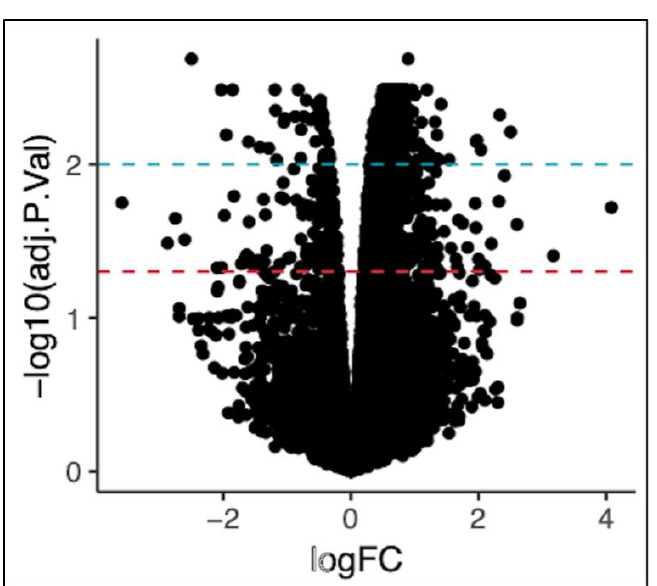
Figure 1. Volcano plot of the distribution of magnitude and significance of all genes. Log fold change (log2) is represented on the x -axis. Significance (log10 adjusted p -value) is represented on the y -axis. The red line indicates p adj = 0.05 and the blue line indicates p adj = 0.01.